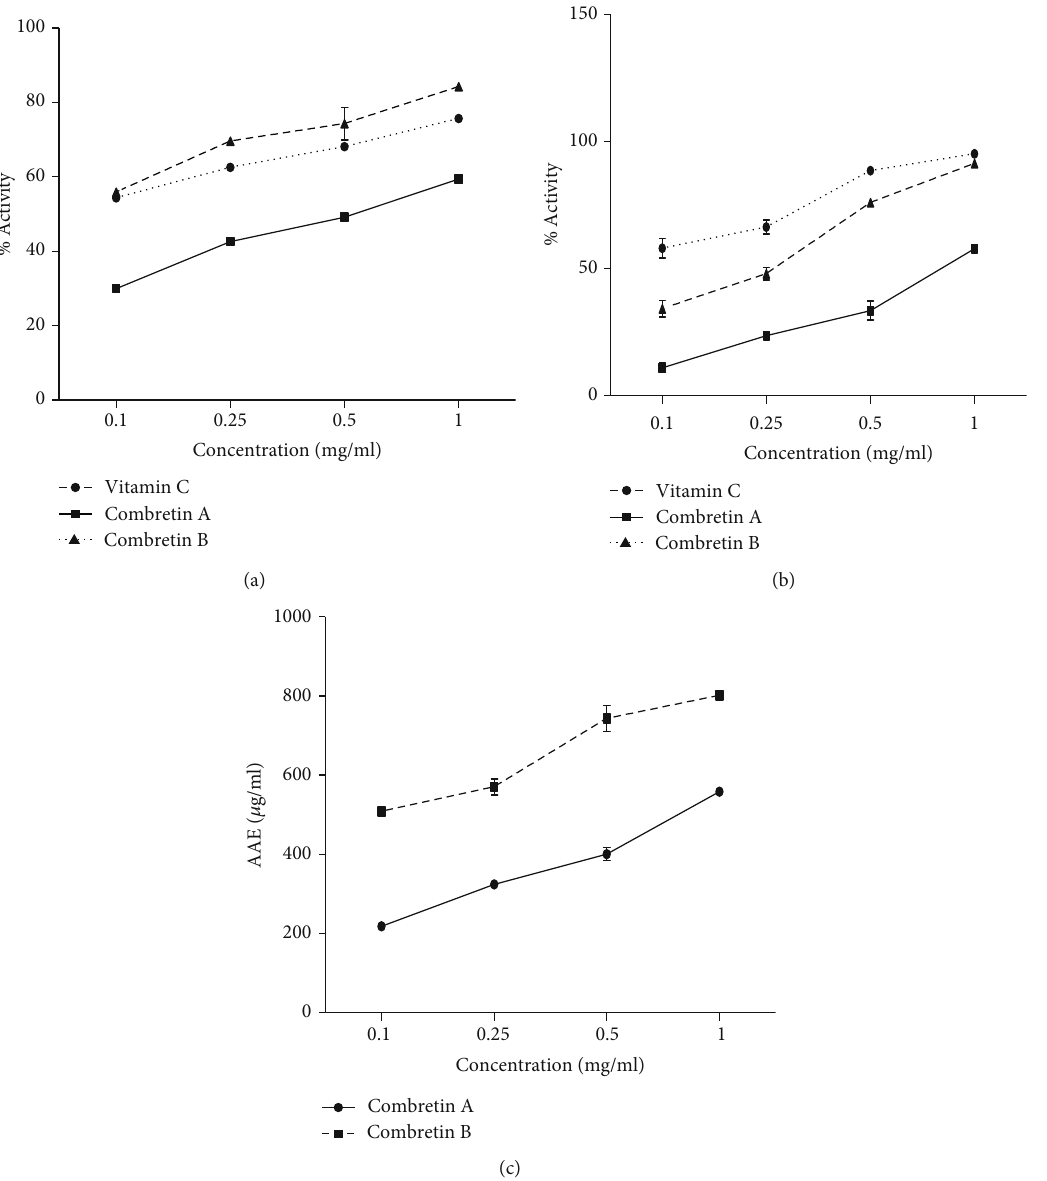
Figure 1: Antioxidant capacity of Combretin A and Combretin B on ABTS (cid:129) + radical assay (a) expressed as percentage activity, and on DPPH assay (b) as a function of time for 30 min and FRAP assay in terms of Ascorbic Acid Equivalents (AAE). Each point represents the mean of three